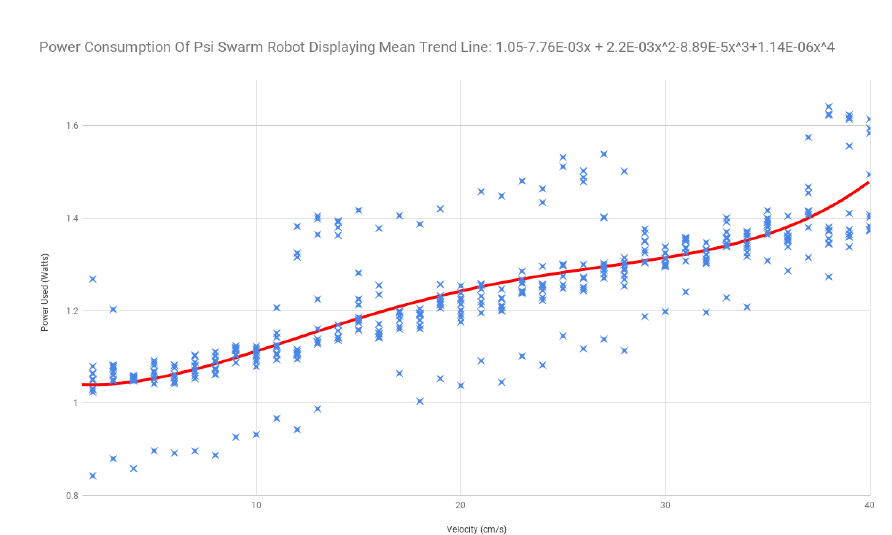
Figure 2. Graph displaying the results of the power consumption of a Psi Swarm robot increasing motor speed gradually. 10 repetitions were taken for these results and a trend line has been fit to the mean of these results and is shown in red.